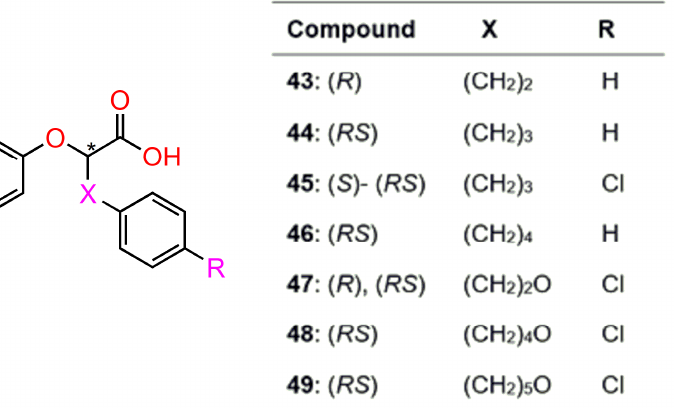
Figure 20. The structure of selected phenoxyacetic acid derivatives prepared as racemate and single enantiomers ( 43 – 49 ). * stereogenic centre.